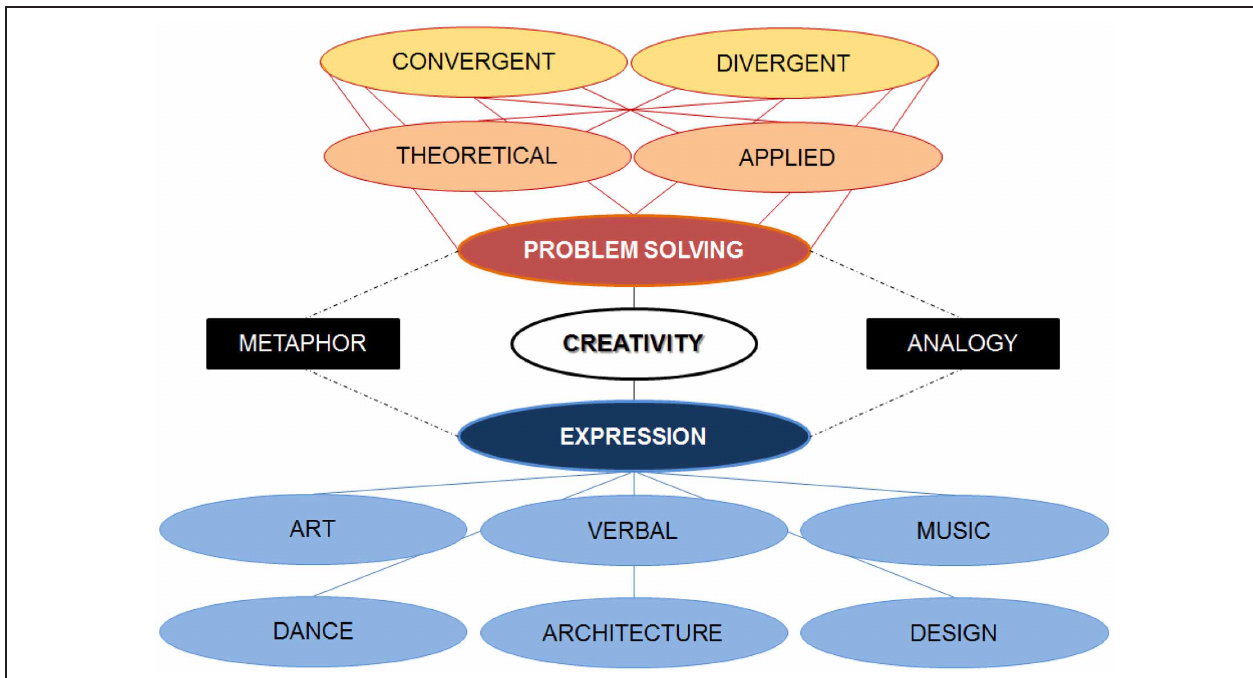
FIGURE 2 | A preliminary framework to distinguish between branches of creativity: problem solving domain and the expression domain. There are subdomains (within oval forms) within each domain and strategies (within rectangular forms) common to both